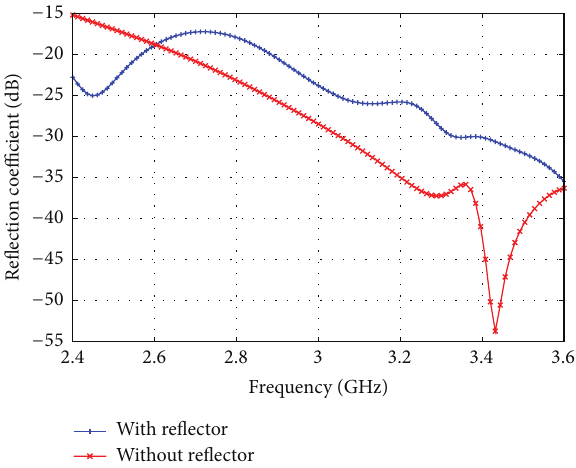
Figure 9: Reflection coefficient computed using HFSS, with no- reflector case shown in red (dashed), and with reflector in